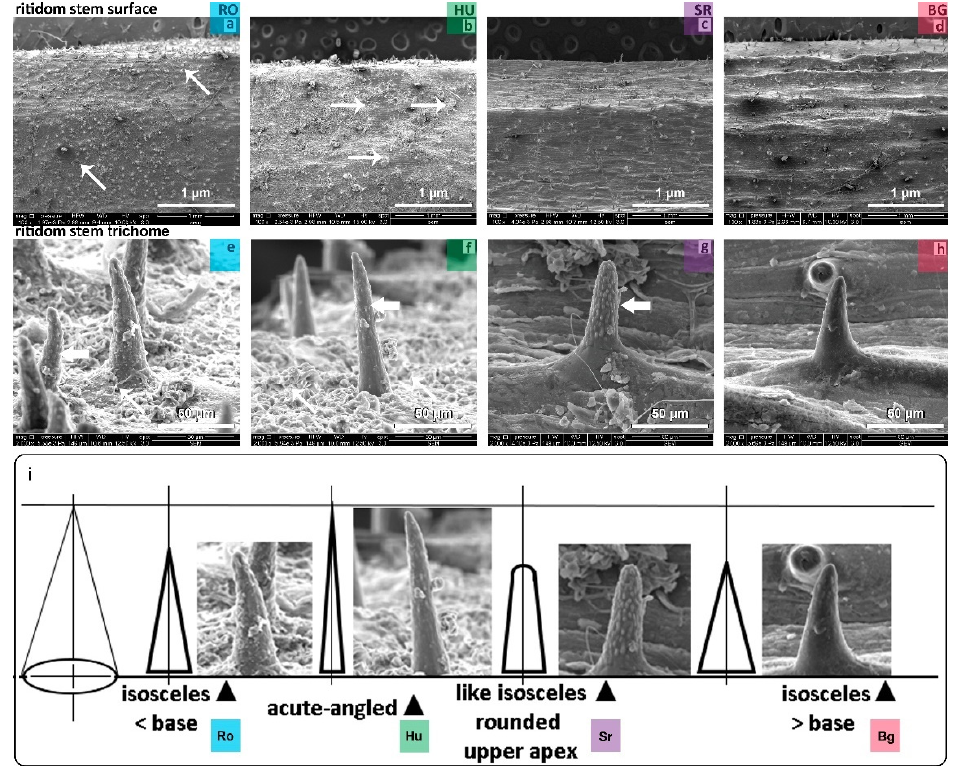
Figure 5. Phenotypic assessment of stem surfaces ( a – d ) and trichome morphologies ( e – h ). Fungal hives developed deposit structures on RO and HU stem surfaces (( a , b ) thin arrows) and cuticle deposits covering the stem-specific insertion base of stem trichomes in RO and HU ( e , f ). Stem tri- chomes with isosceles triangle-like shapes with different bases ( i ): lower base in RO/HU with an acute-angle apex ( e , f ). Stem trichome surfaces—verrucous structures in SR ( g , thick arrow), moder- ate verrucous surface for RO and HU ( e , f , thick arrow) and underrepresented or totally absent in the BG samples ( h ).